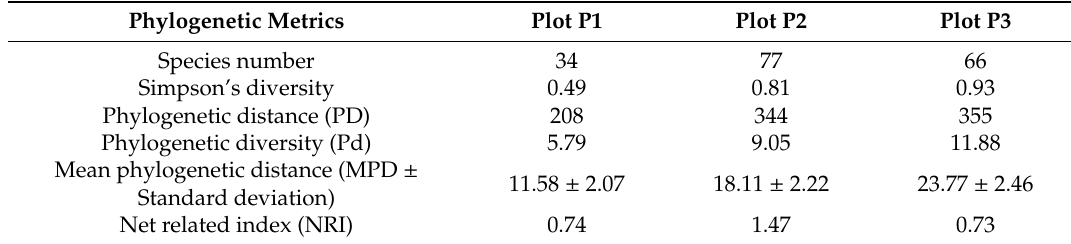
Table 2. Phylogenetic diversity of three sampled